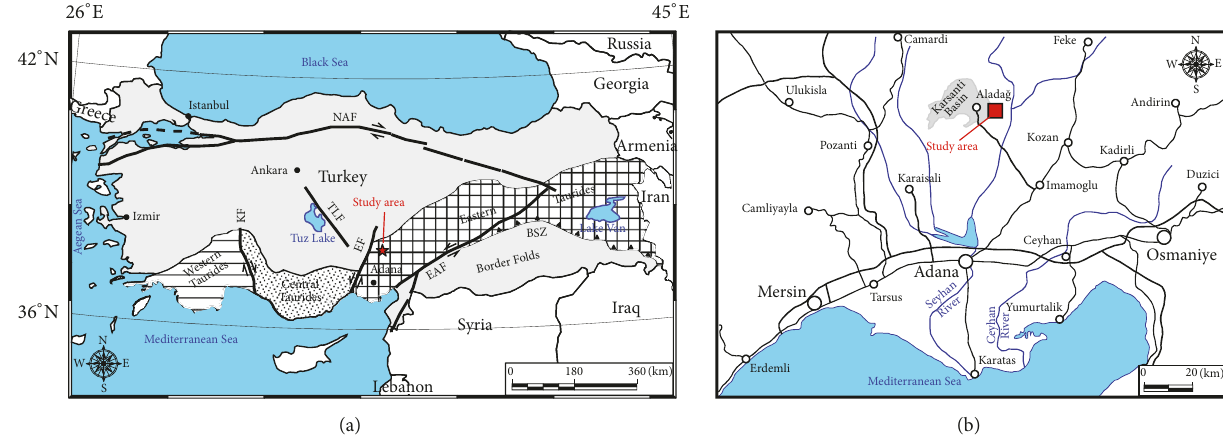
Figure 1: (a) The broad geographical subdivision of the Taurides (after [33]) and major tectonic structures in Turkey (KF = Kırkkavak Fault, EF = Ecemis¸ Fault, TLF = Tuz Lake Fault, EAF = East Anatolian Fault, NAF = North Anatolian Fault, BSZ = Bitlis Suture Zone) (modified from [34]) and (b) location of the Kızılgedik study area in Alada˘g (Adana, Turkey).